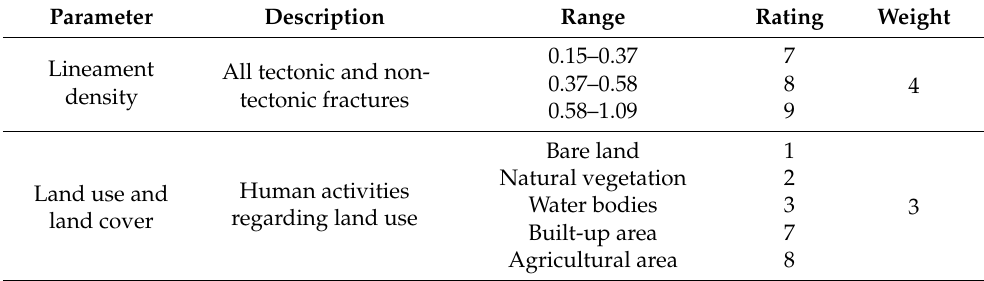
Table 2. Ratings and weights of lineaments and land use in the study area.